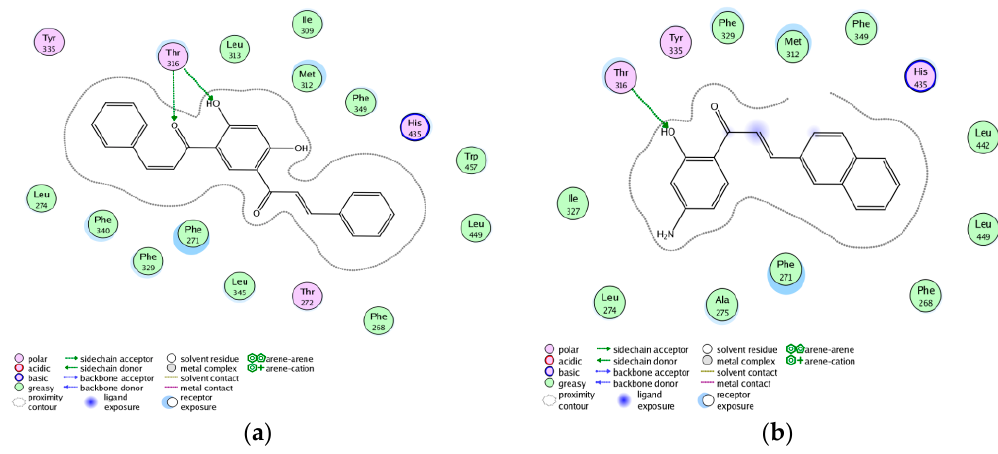
Figure 2. Comparison between the binding mode of ZINC08665430 ( a ) and compound 36 ( b ) in the LXR β active site. Table 5. Chemical structures of newly-screened ABCA1 up-regulator targeting LXR β .